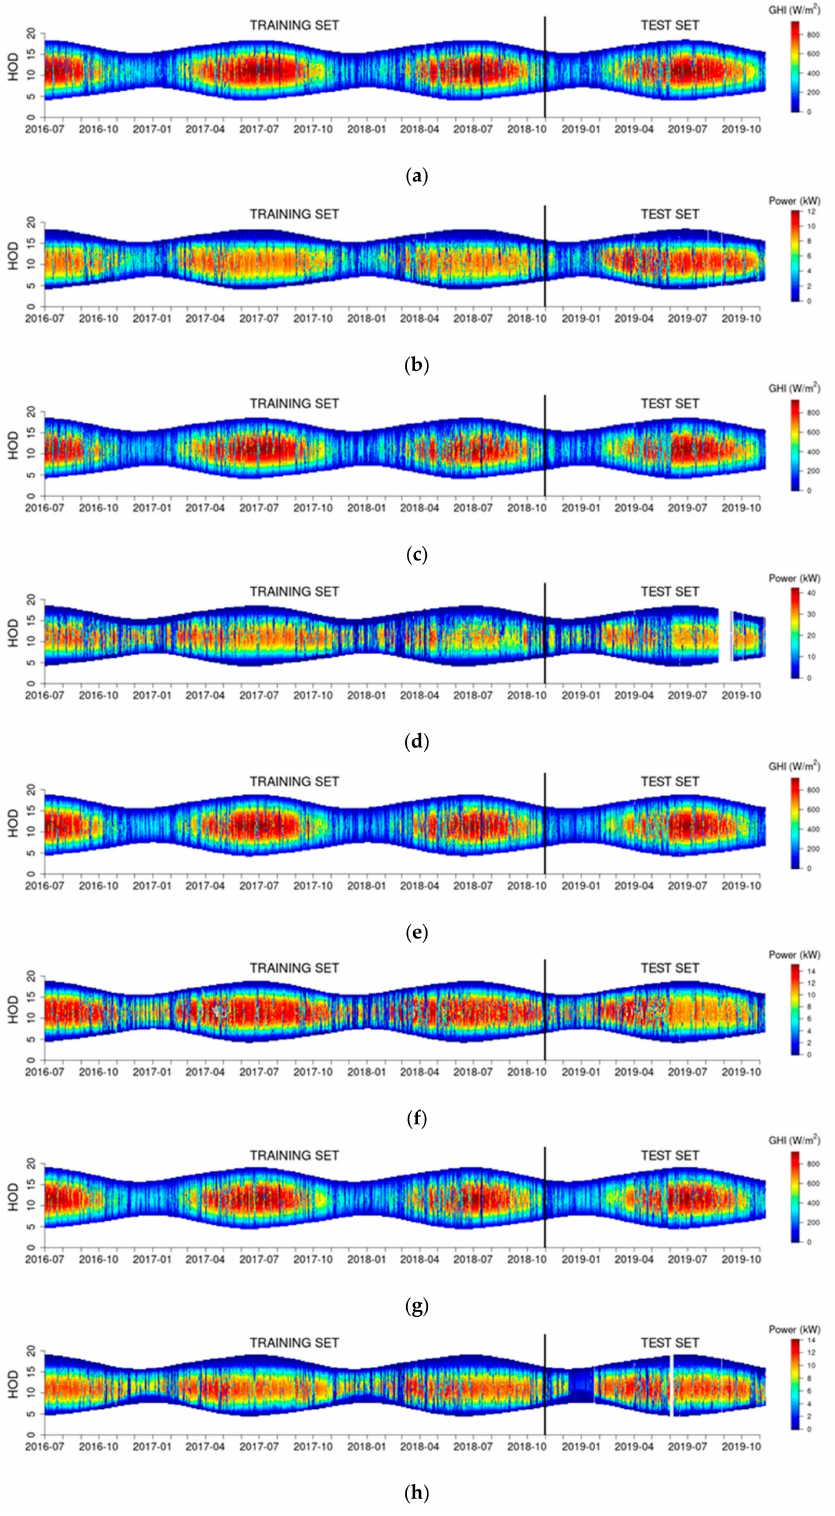
Figure 2. From top to bottom, heatmaps of Hour Of the Day vs. day of the year of measurements of ( a ) GHI of plant P1, ( b ) PV power production at the plant P1; ( c ) GHI of plant P2, ( d ) PV power production at the plant P2; ( e ) GHI of plant P3, ( f ) PV power production at the plant P3; ( g ) GHI of plant P4, ( h ) PV power production at the plant